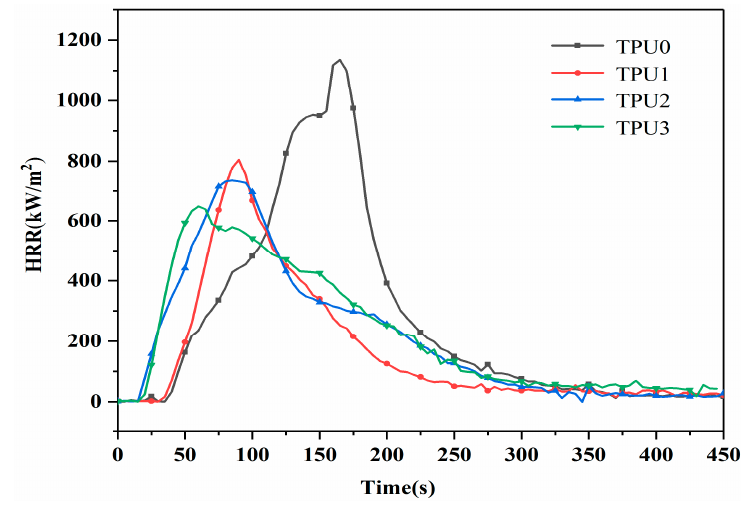
Table 2. Cone calorimeter data of TPU composites.